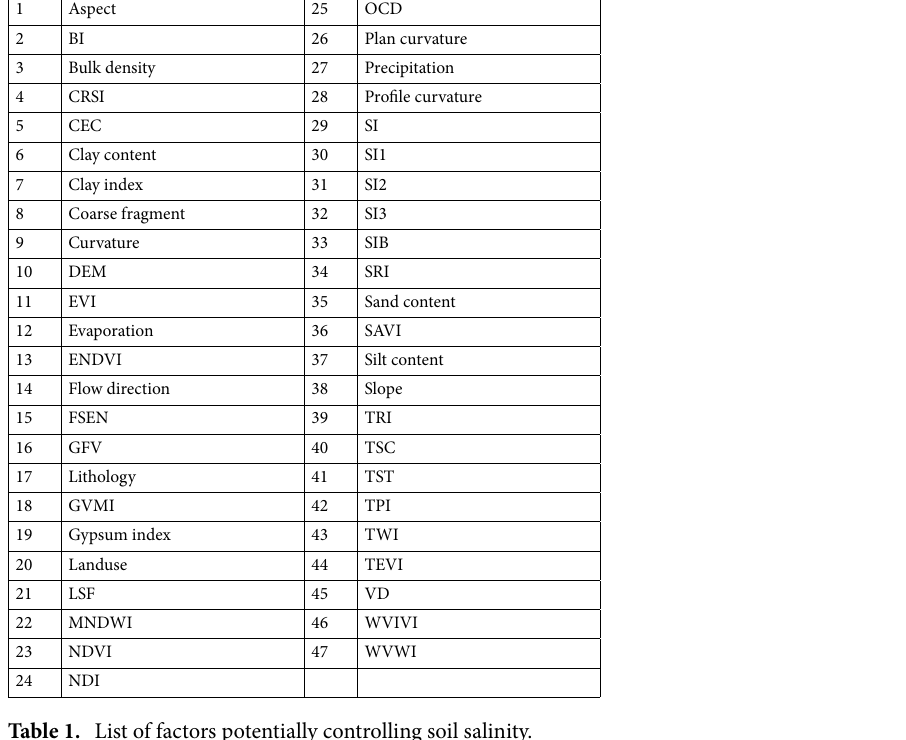
Table 1. List of factors potentially controlling soil